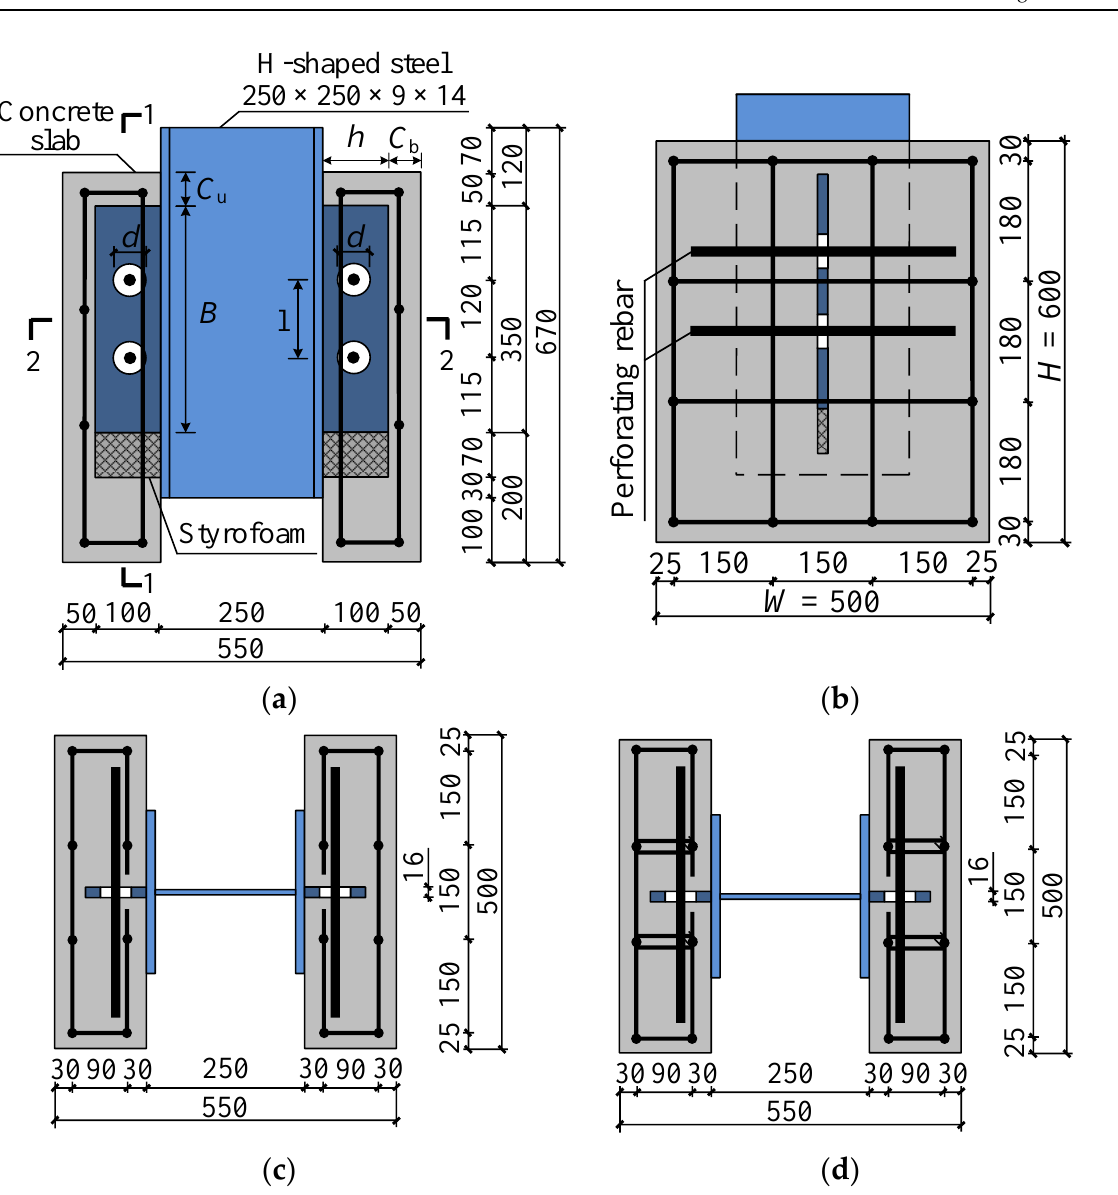
Figure 3. Structural diagrams of push-out specimens (units: mm): ( a ) Front view; ( b ) Section 1-1; ( c ) Section 2-2 (conventional stirrups); ( d ) Section 2-2 (segmented stirrups).